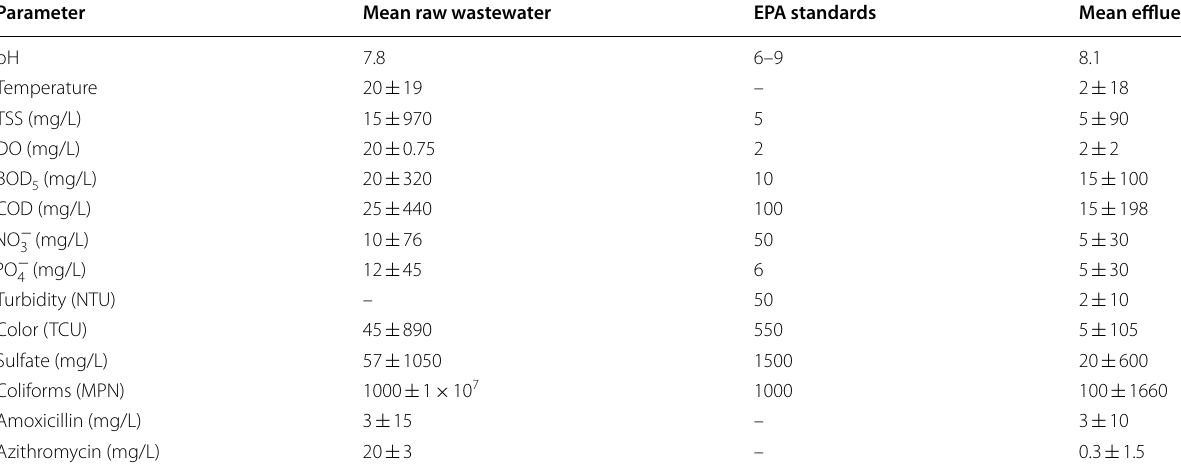
Table 1 Characteristics of raw wastewater and effluent from wastewater treatment